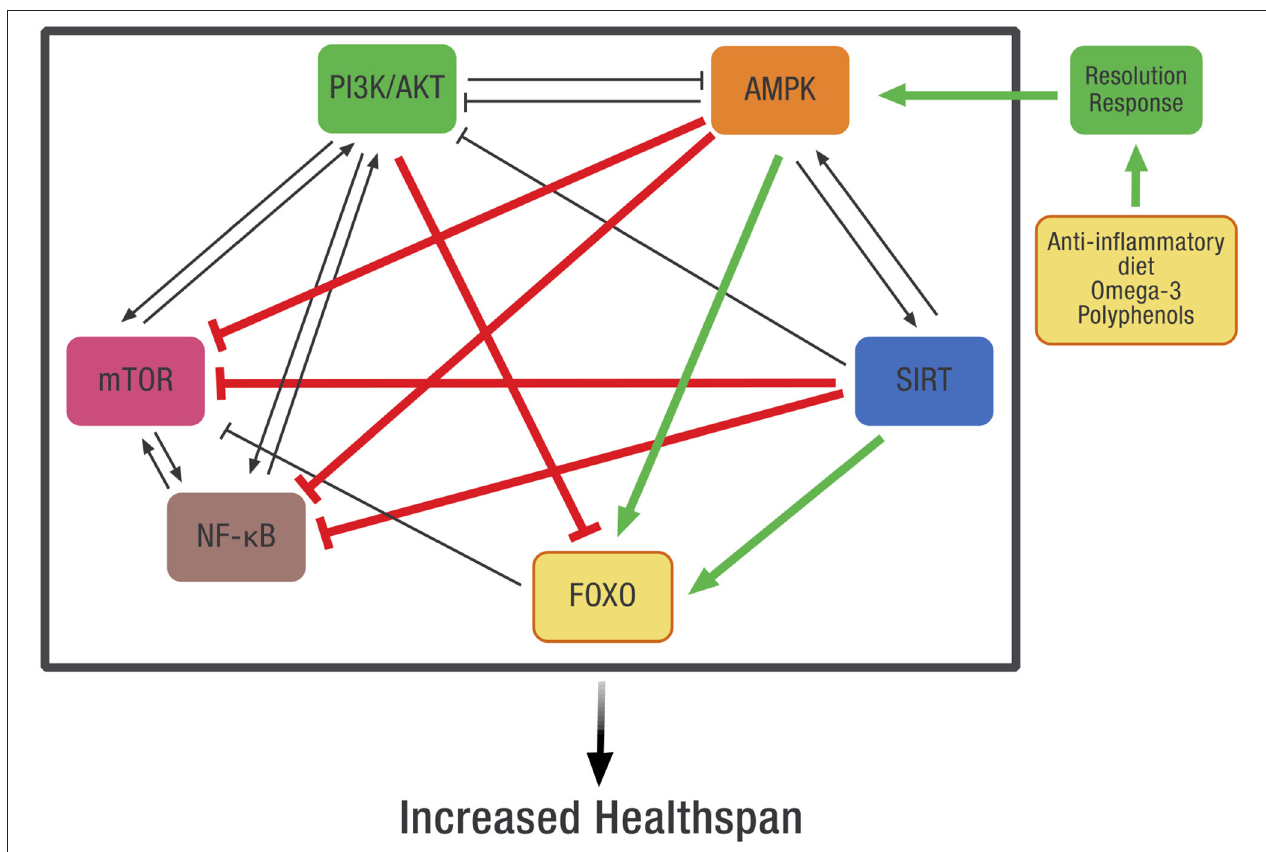
FIGURE 8 | The potential effect of dietary optimization of the Resolution Response on various regulatory proteins and gene transcription factors. AMPK, 5’ adenosine monophosphate-activated protein kinase; FOXO, Forkhead box transcription factors class O; mTOR, mammalian target of rapamycin; NF- κ B, Nuclear factor kappa-B; PI3K/AKT, Phosphatidylinositol 3-kinase/AKT (protein kinase